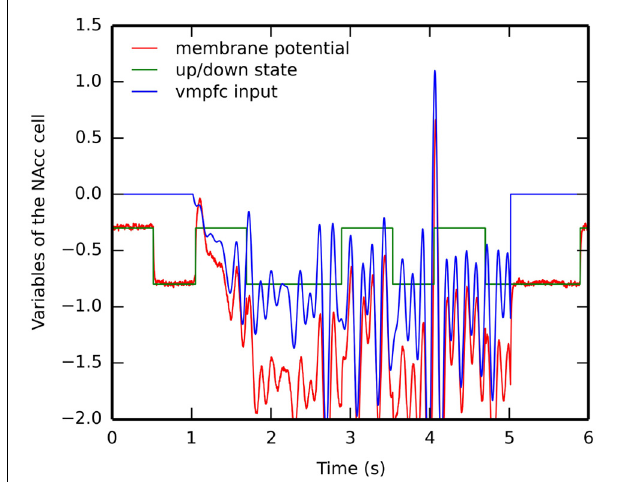
FIGURE 8 | Timecourse of the internal variables of a single NAcc neuron during a reward omission trial. After the conditioning phase, CS2 is presented alone. The NAcc neuron which was selective for US2 during conditioning is recorded: its membrane potential m ( t ) in red, the weighted sum of excitatory inputs from vmPFC in blue and its up- or down-state s ( t ) in green. The firing rate of the neuron is the positive part of the membrane potential: the firing rate becomes only non-zero shortly at the time where reward is expected but omitted.